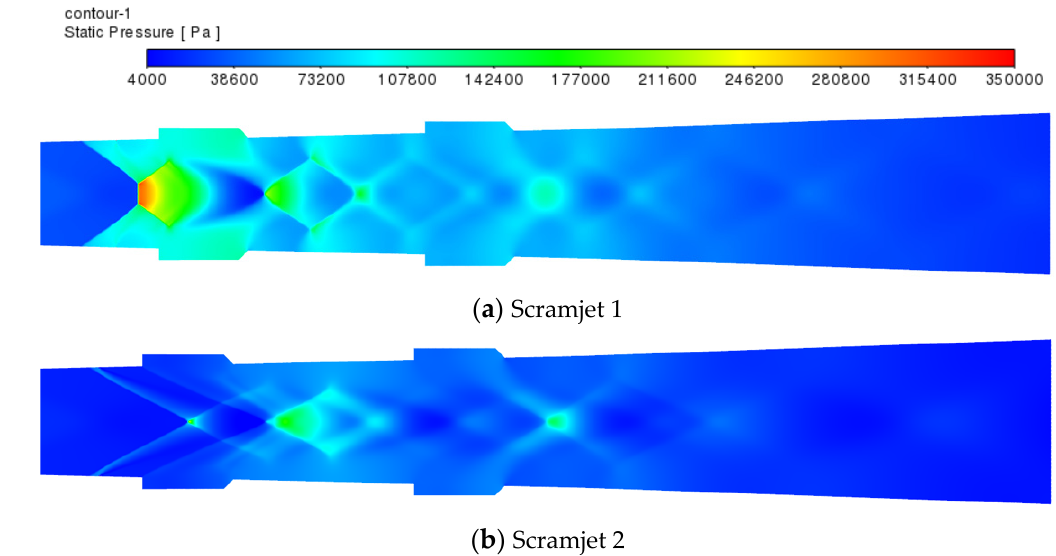
Figure 7. Static pressure contours for scramjet 1 and scramjet 2.